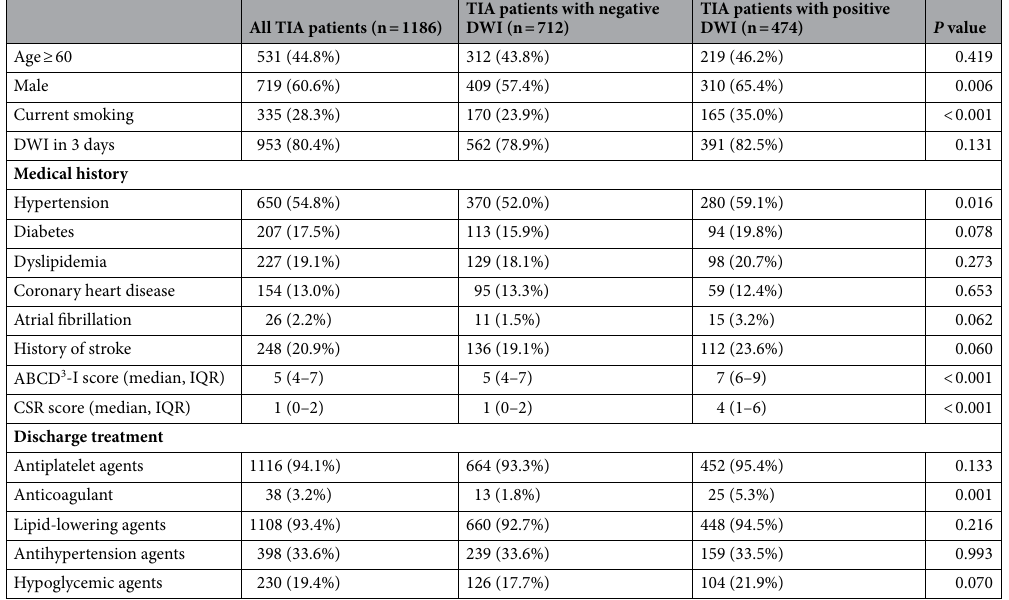
Table 2. Baseline characteristics of enrolled TIA participants. TIA transient ischemic attack, DWI diffusion- weighted imaging, CSR comprehensive stroke